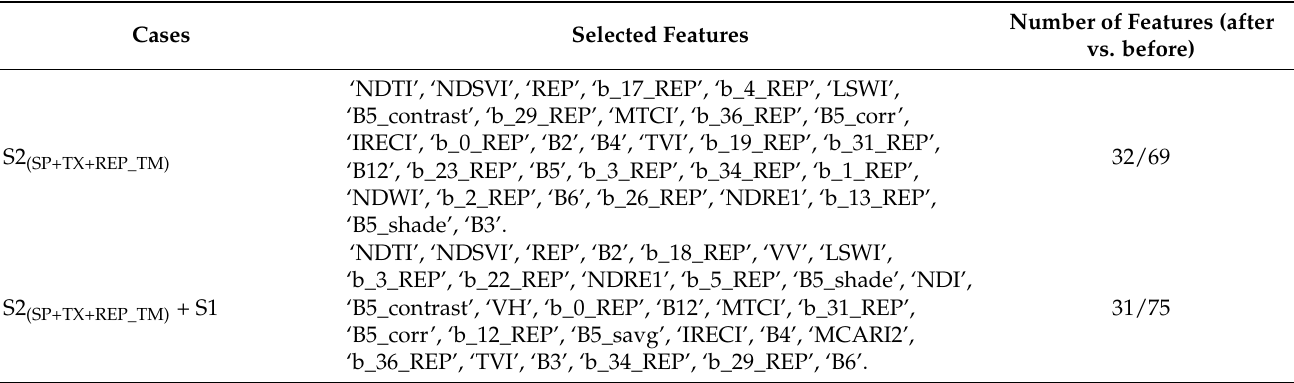
Table A6. The selected features use the relevance hierarchical clustering